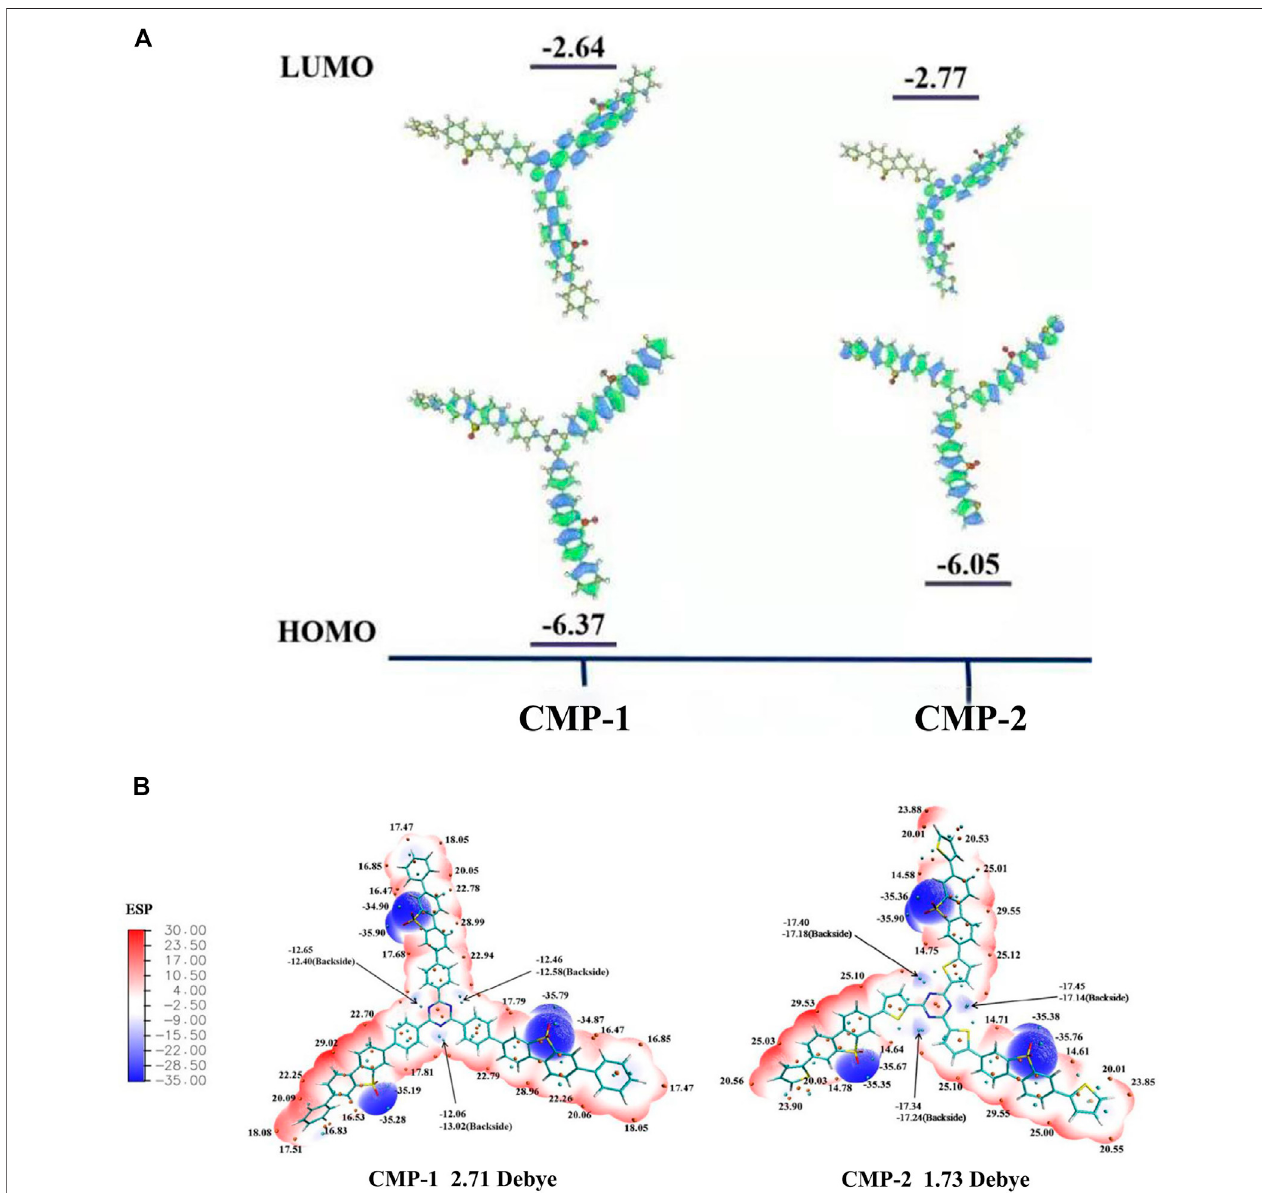
FIGURE 5 | (A) HOMO and LUMO orbits distribution of the polymers from DFT calculation. (B) Diagram of molecular dipoles and surface electrostatic potential in CMP-1 and CMP-2.